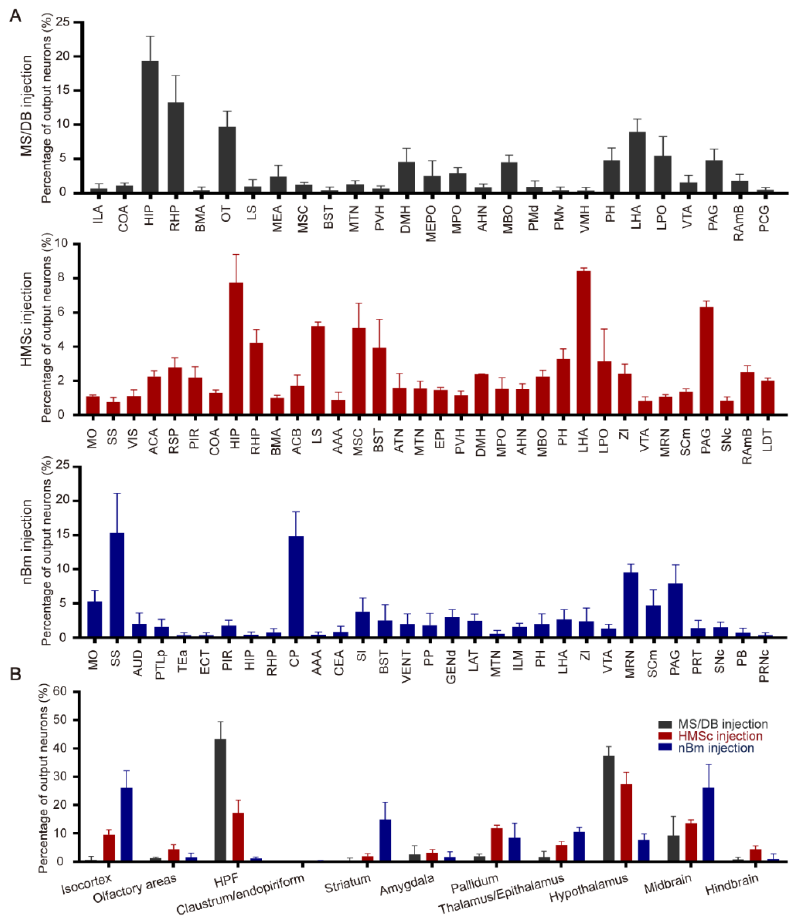
Figure 3. Quantitative analysis of neurons labeled in each brain region across the whole brain. ( A ) Proportion of whole-brain outputs of cholinergic neurons in the different subregions of the basal forebrain, MS/DB (top), HMSc (middle), and nBm (bottom). ( B ) The proportion of given brain regions receiving cholinergic neuronal projections from the three different subregions.